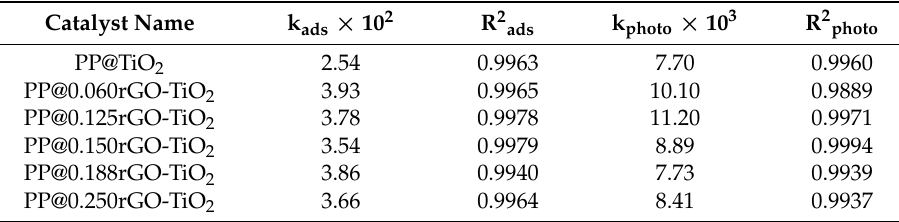
Table 2. k ads and k photo values with R 2 for all